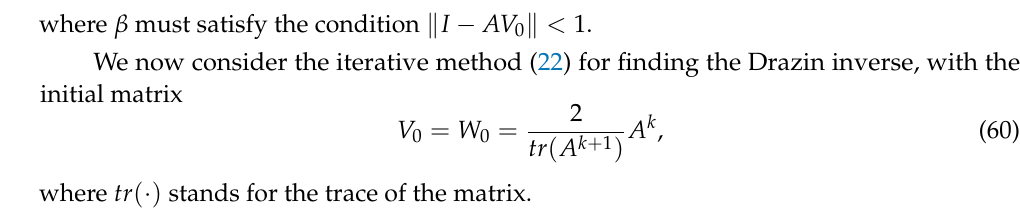
Table 2. Computational cost for every iteration of the methods. Method CO